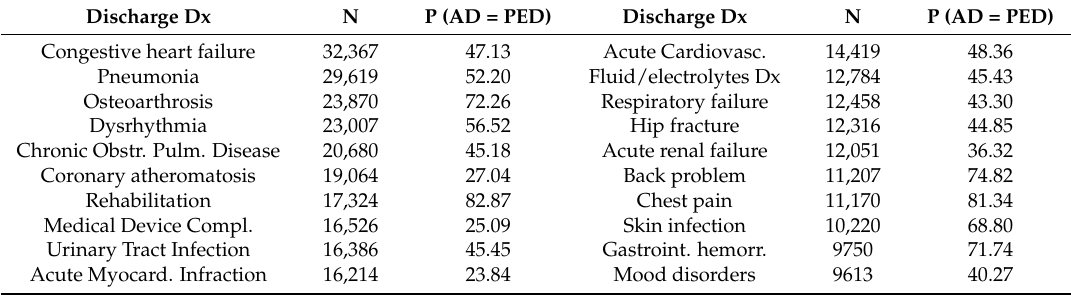
Table 2. Correct diagnosis % (admission = discharge D x ), for the 20 most frequent Clinical Classification Software (CCS) Principal Exit Diagnoses.